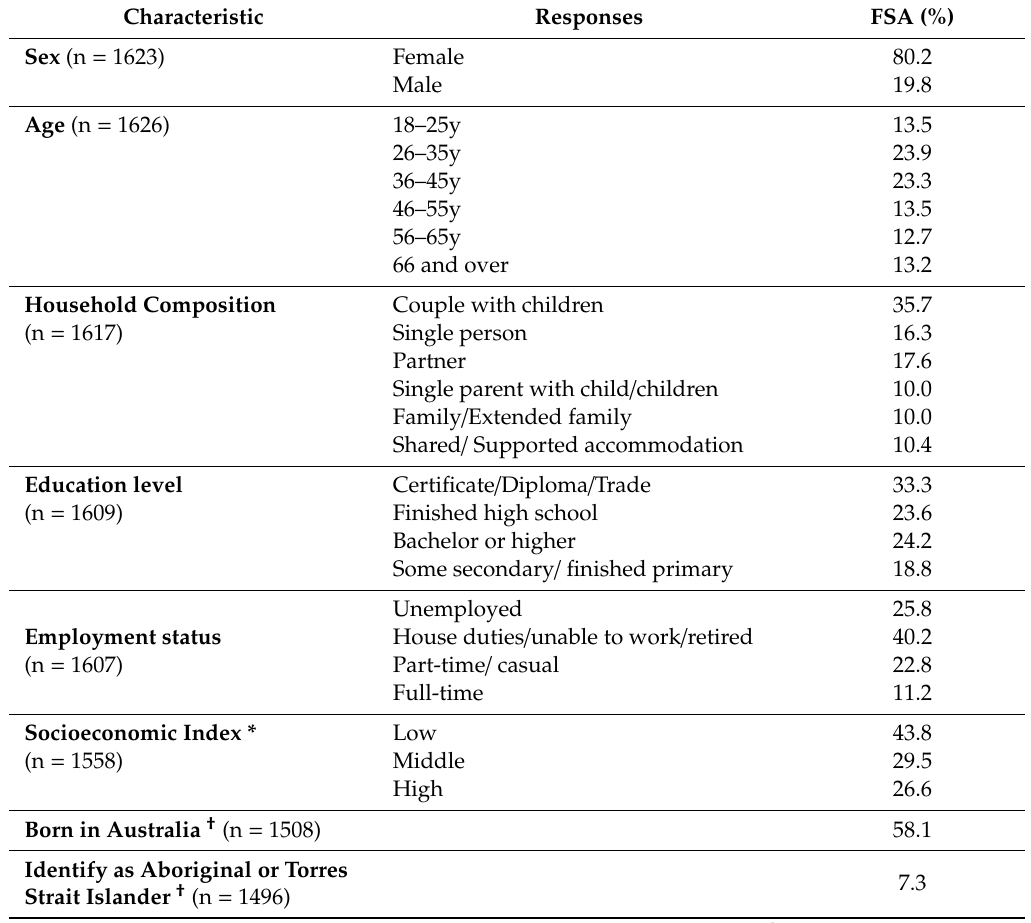
Table 1. Demographic characteristics of FSA participants